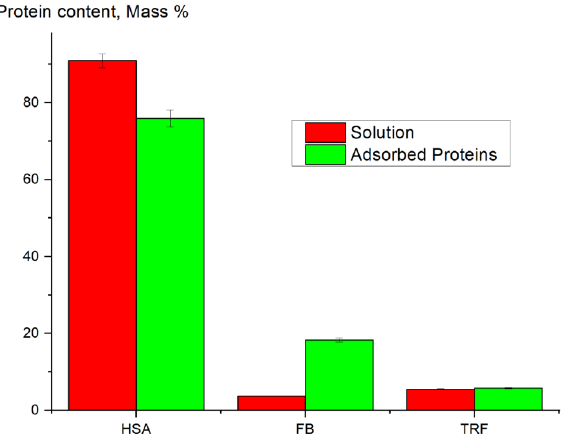
Figure 4. Comparison between the protein composition in the initial solution and that in adsorbed proteins from a multi-protein